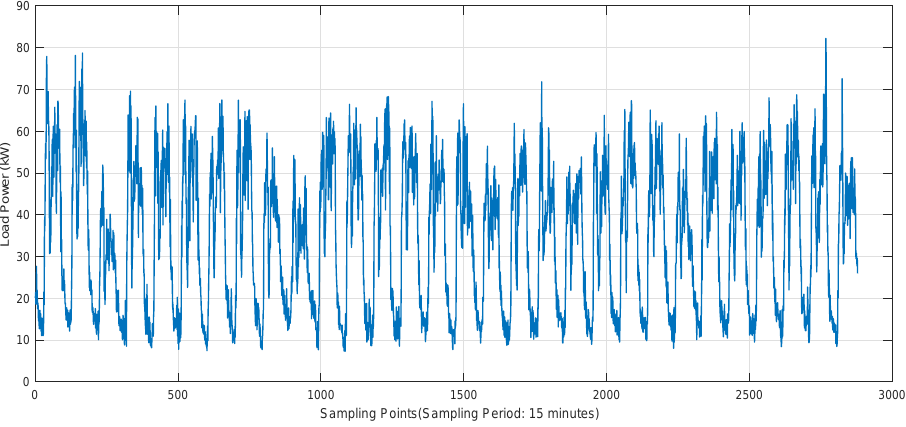
Figure 4. Load curve of Customer 53990001 from Feeder 2 during a month, where the sampling period is 15